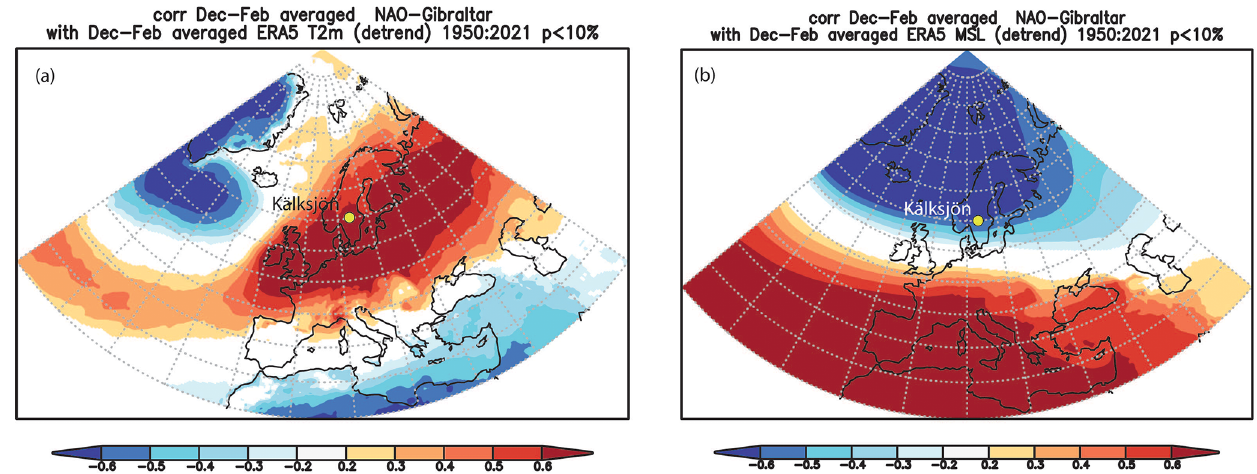
Figure 11. Correlation of North Atlantic Oscillation index (Jones et al., 1997) with (a) sea level temperature and (b) sea level pressure from the ERA5 reanalysis (Hersbach et al., 2020) for the period 1950 to 2021 during winter (DJF).